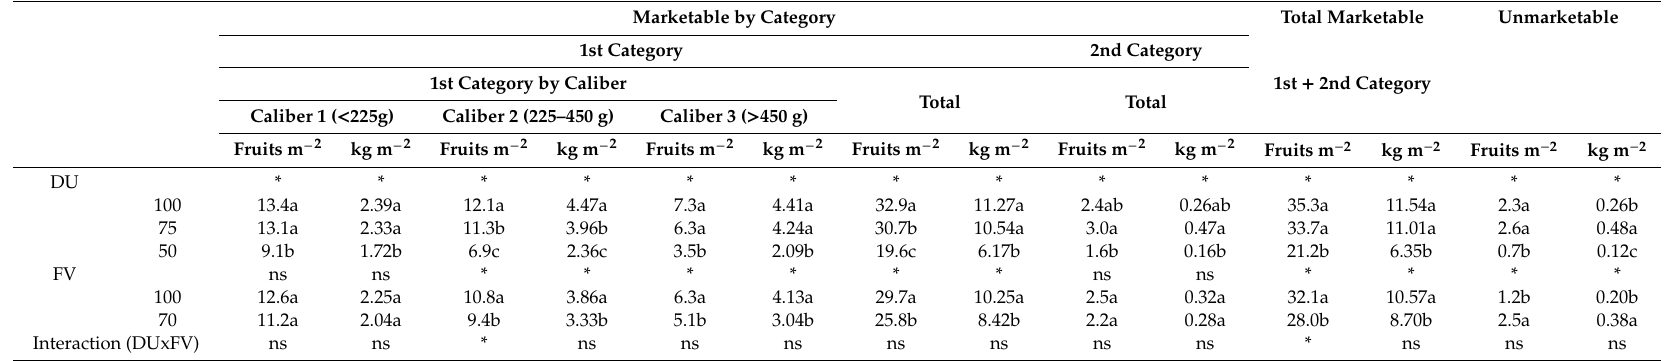
Table 2. Marketable yield by categories and calibers, and unmarketable zucchini yield. Fresh fruit weight (kg m − 2 ) and and number of fruits (Fruits m − 2 ). Marketable by